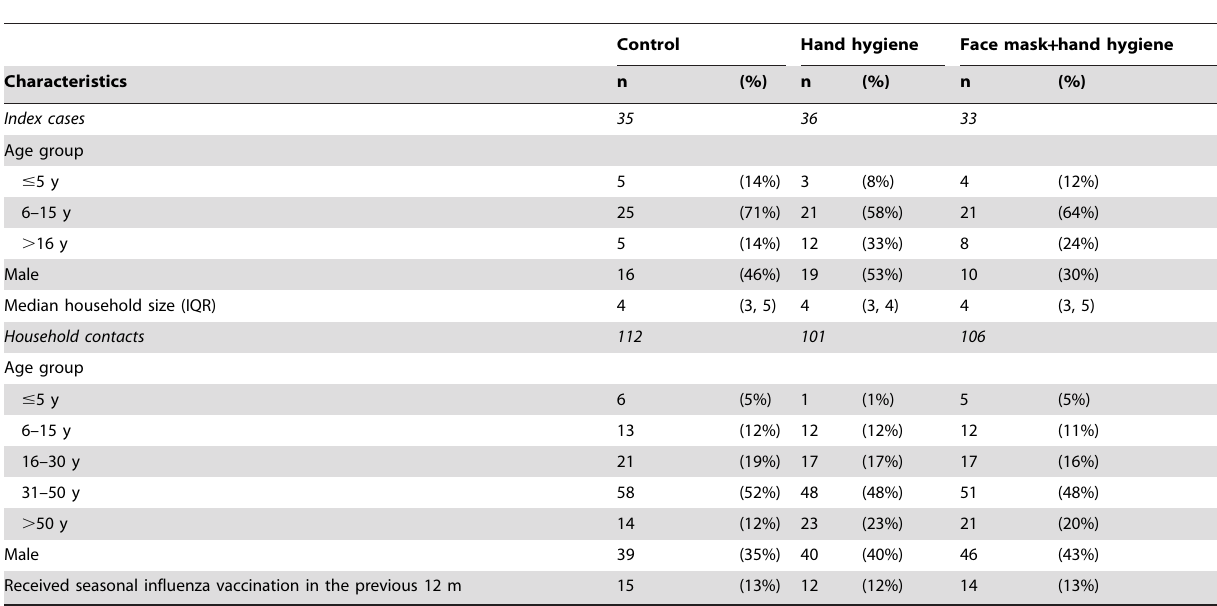
Table 2. Characteristics of index cases with confirmed influenza B virus infection and their household contacts in Hong Kong, by intervention group.